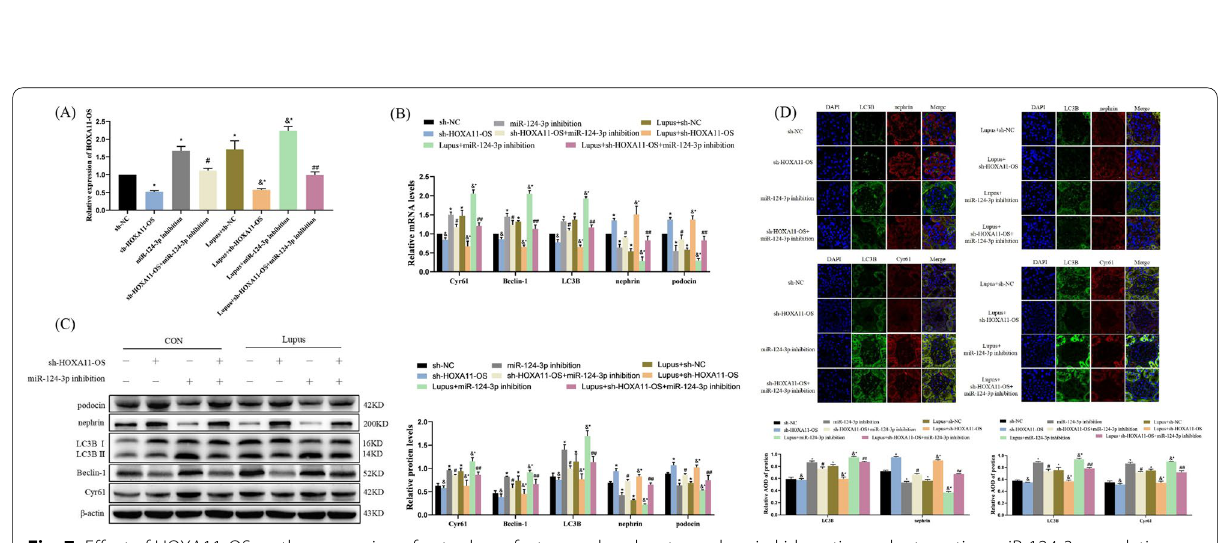
Fig. 7 Effect of HOXA11-OS on the expression of autophagy factors and podocyte markers in kidney tissues by targeting miR-124-3p regulating Cyr61. A The expression of HOXA11-OS mRNA was detected by qRT-PCR after AAV was injected into mouse kidney tissues. B The expression of Cyr61, Beclin-1, LC3B, nephrin, and podocin in kidney tissues of mice was detected by qRT-PCR and western blotting. C The expression of Cyr61, LC3B, and nephrin in kidney tissues of mice was detected by IF. & P > 0.05, * P < 0.05 vs. sh-NC; # P < 0.05 vs. sh-HOXA11-OS; &* P < 0.05 vs. Lupus ## P < 0.05 vs. Lupus sh-HOXA11-OS. Data are presented as means standard deviation. Scale bars represent 15 + ±